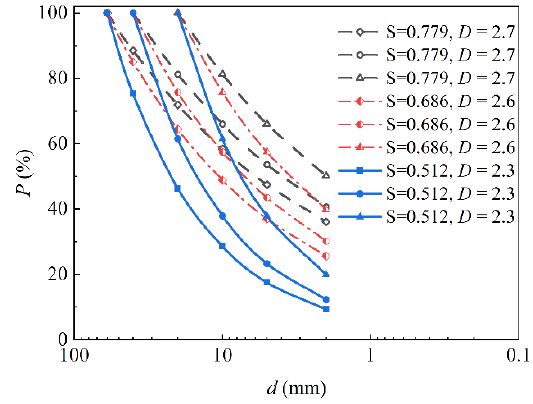
Figure 14. Gradation curves of rockfill materials [29].